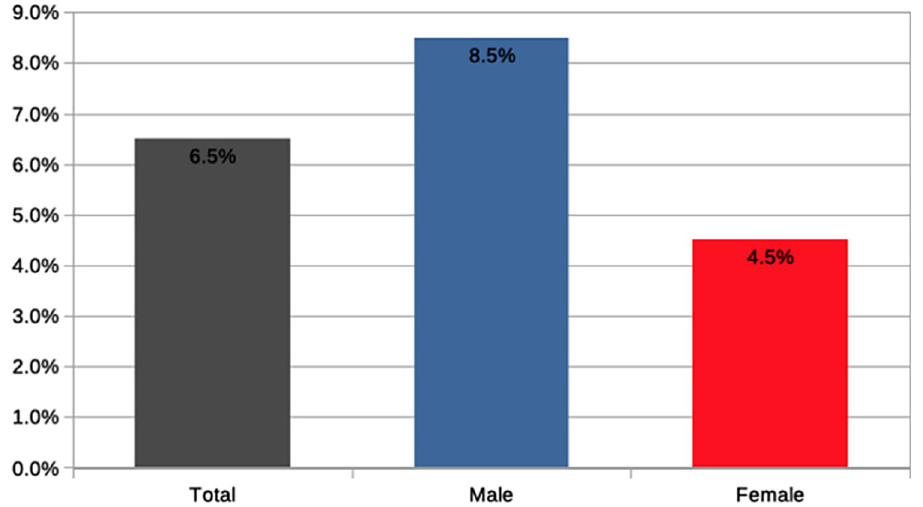
Fig 3. Ph.D. start-up activity by